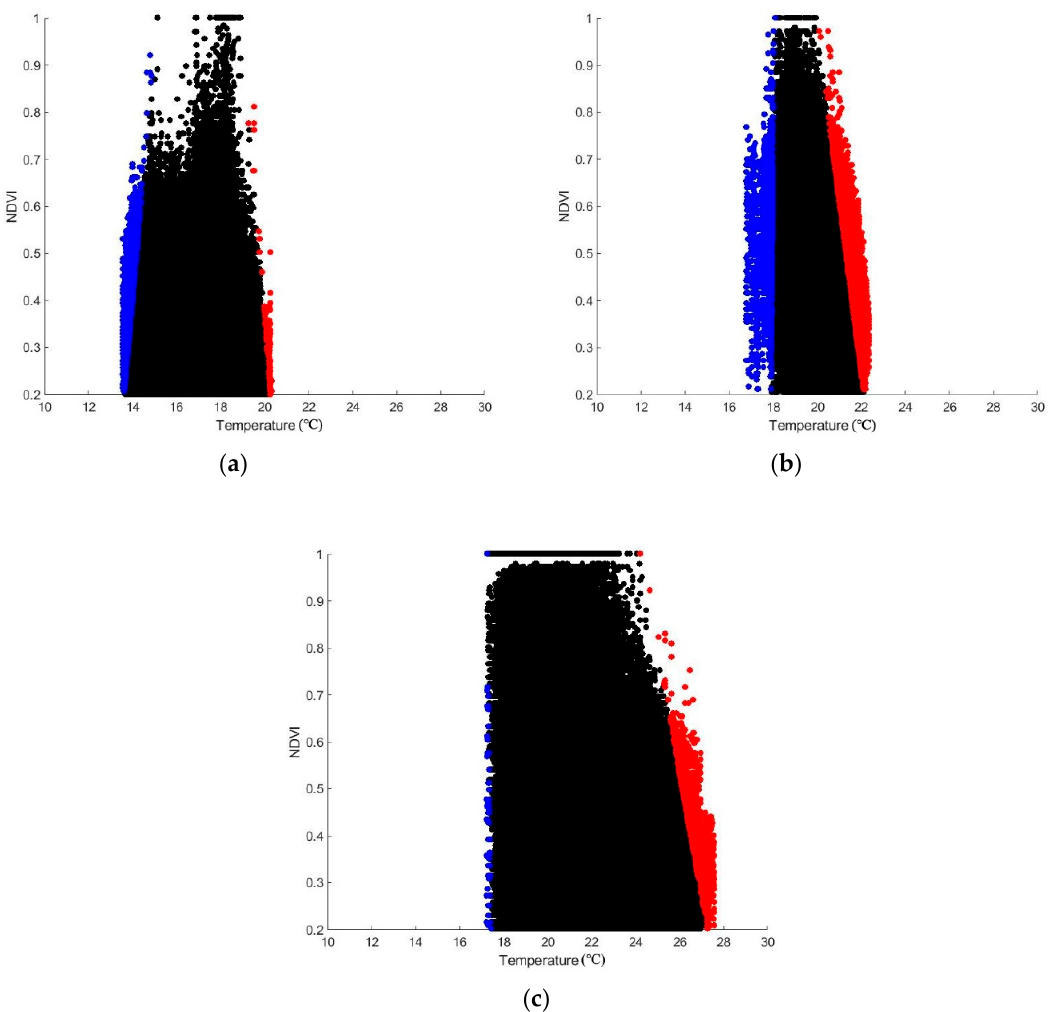
Figure 5. The dry and wet edges of the Ts-NDVI space. ( a ) Site A1; ( b ) Site B1; ( c ) Site C1. The points of the dry edge are in red color; the points of the wet edge are in blue color.